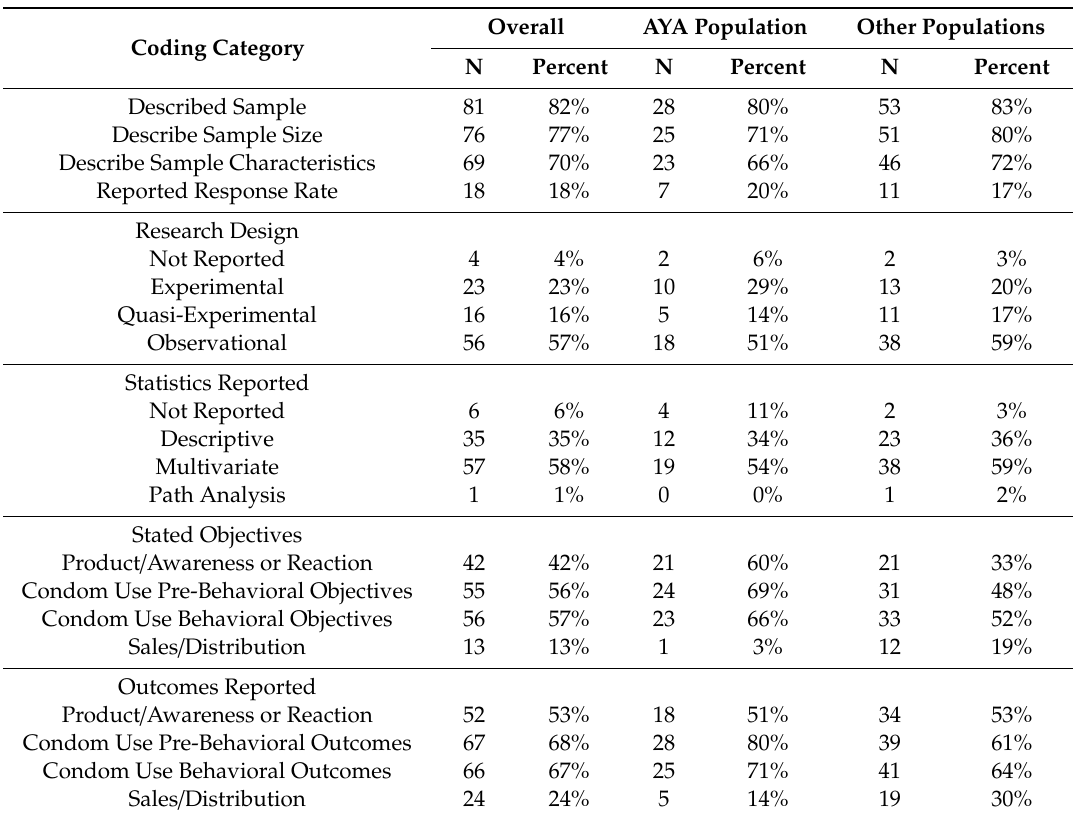
Table 4. Study design and